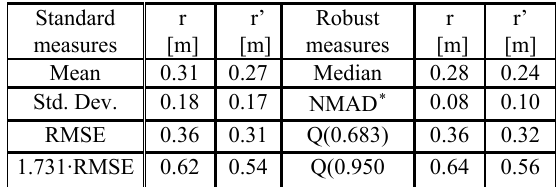
rived from the semi-axes of the confidence ellipse nd the circular error probable (CEP_0.95) are smallest. The accuracy measures based on the radius (r) have higher values than the ones based on the unbiased radius (r’). Q r’ is nearly of the same size as the